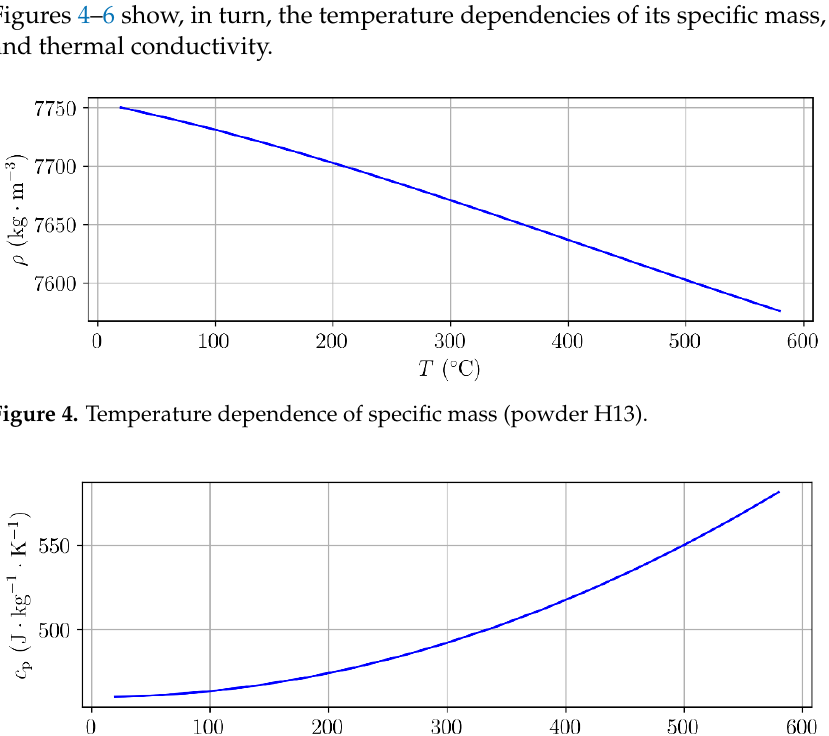
Figure 3. Temperature dependence of specific heat (steel S355).